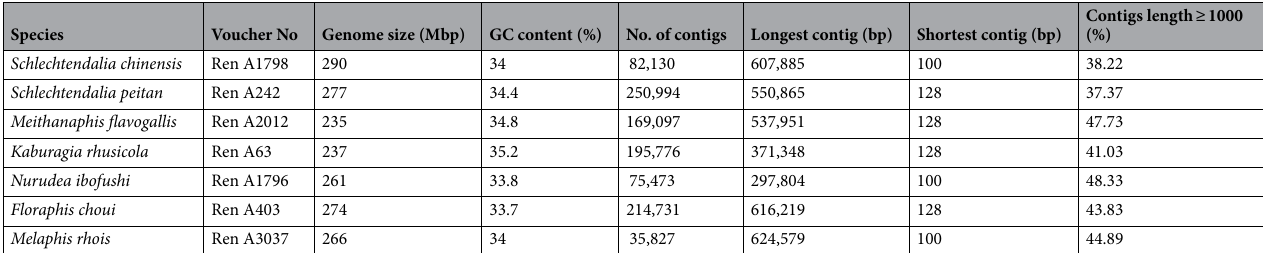
Table 2. Species and genomes of all seven Rhus gall aphids included in this study, and detailed information of the sequenced genomes of all the